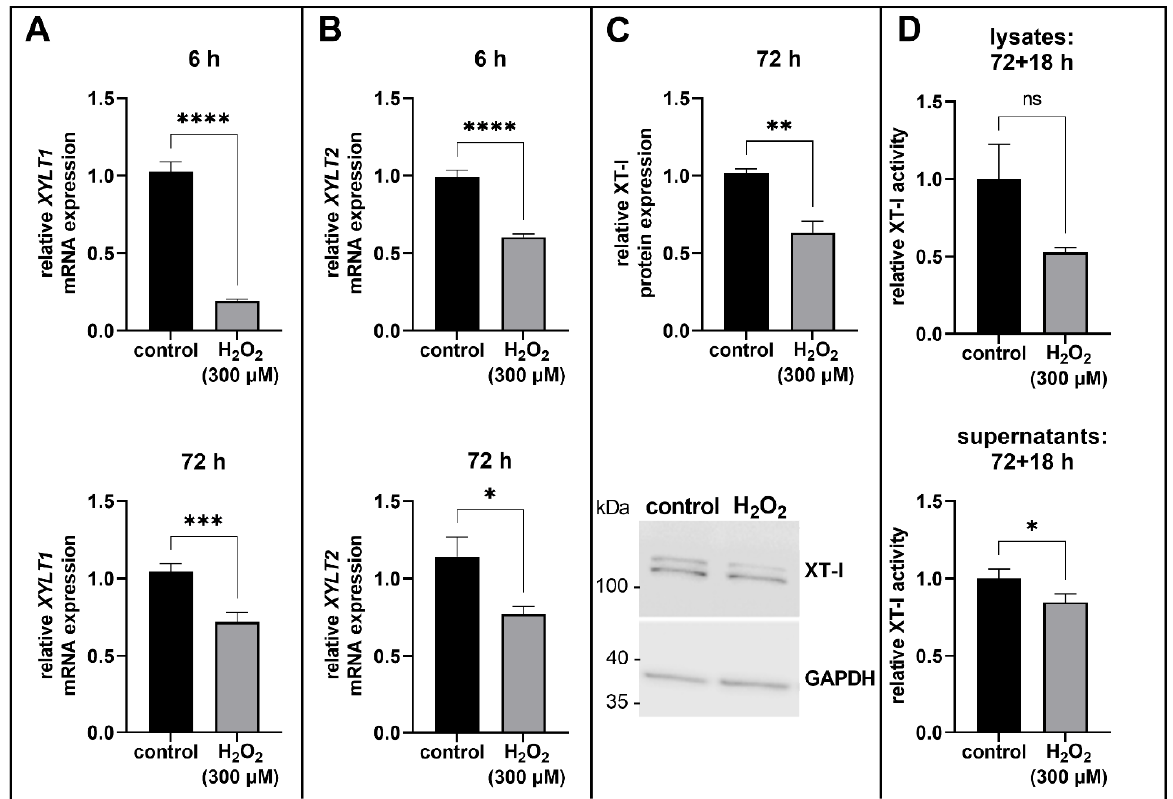
Figure 2. Investigation of the XYLT mRNA and XT-I protein expression level in acute senescent proto-myofibroblasts. After 24 h of cultivation, cells were treated for 1 h with 300 µ M H 2 O 2 or H 2 O (control). XYLT 1 ( A ) and XYLT2 ( B ) mRNA expression levels were analyzed after 6 or 72 h of cultivation by quantitative real-time PCR and were normalized on GAPDH mRNA expression level. The XT-I protein expressions in cell lysates were detected via immunoblotting 72 h after H 2 O 2 treatment and were normalized on GAPDH protein expression. Quantification was determined using ImageJ ( C ). The intra- and extracellular XT-I enzyme activities were determined after 72 + 18 h by a XT-I-selective mass spectrometric assay (UPLC/ESI-MS/MS assay) and were normalized on total protein concentrations ( D ). The values shown are means ± SEM for three biological and three ( A , B , D ) or one ( C ) technical replicate per experiment (n = 3) and calculated relative to the respective control.